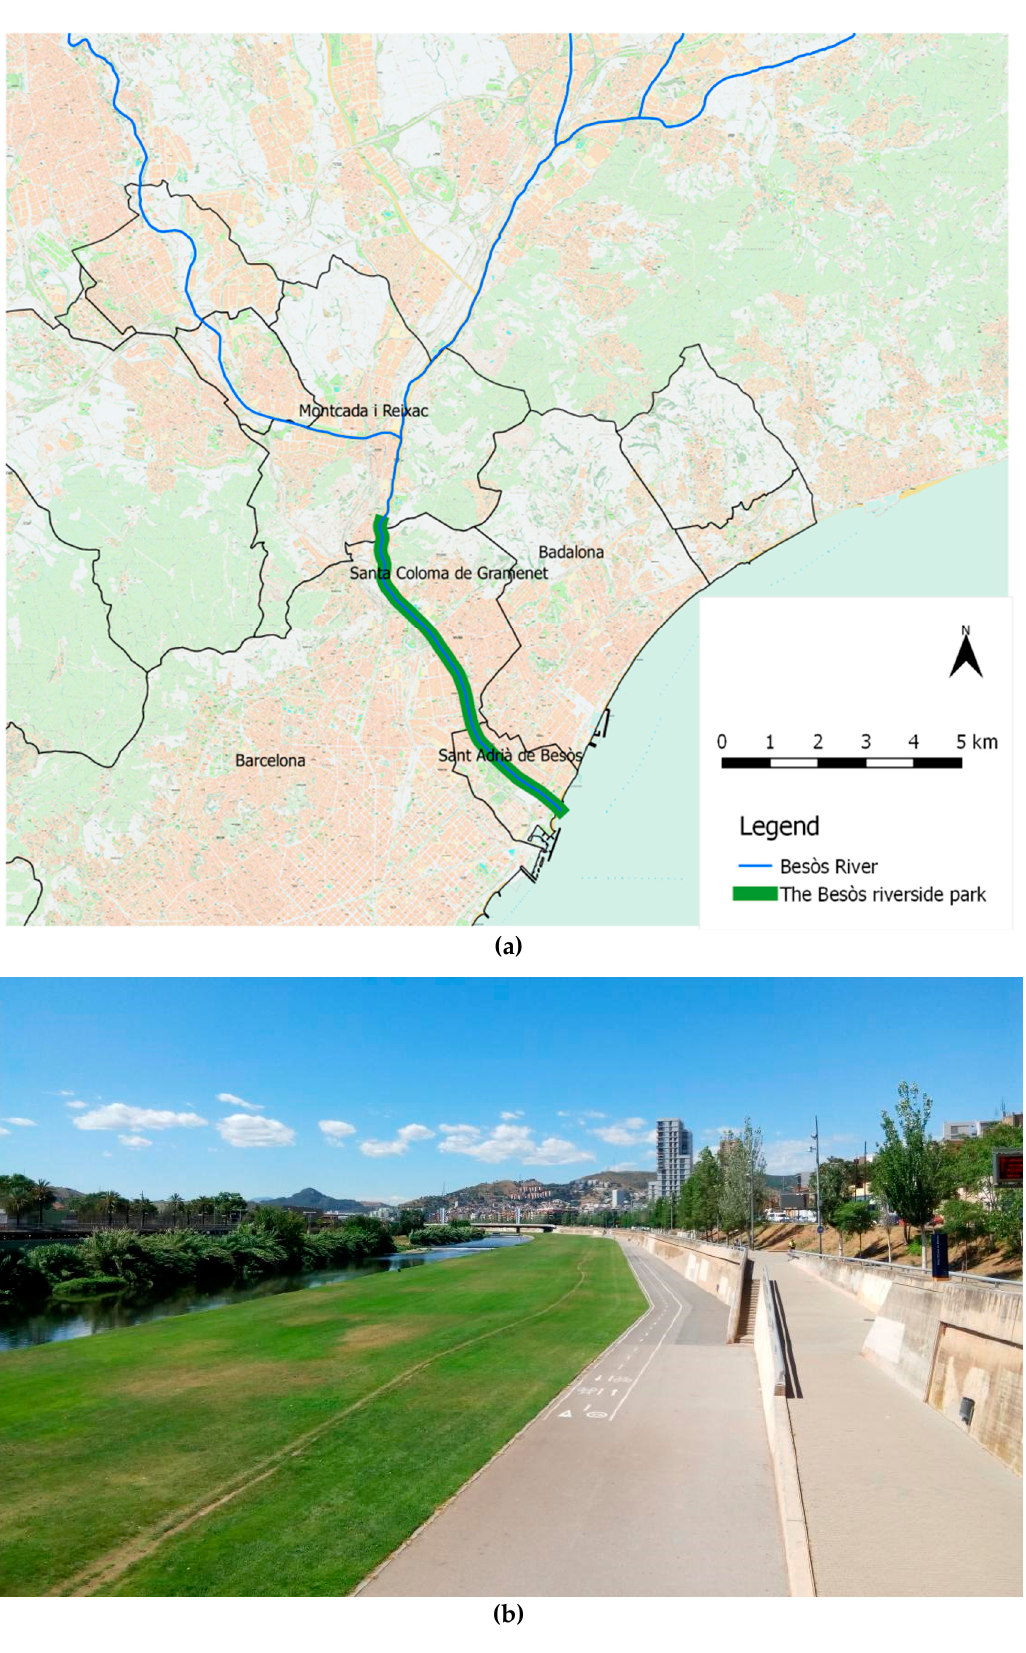
Figure 1. Setting of the study area: (a) Map of The Besòs Riverside Park, which spans the last 9 km of the Besòs River [40]; (b) The Besòs Riverside Park (Image: Cristina Vert/ISGlobal, May 2017).